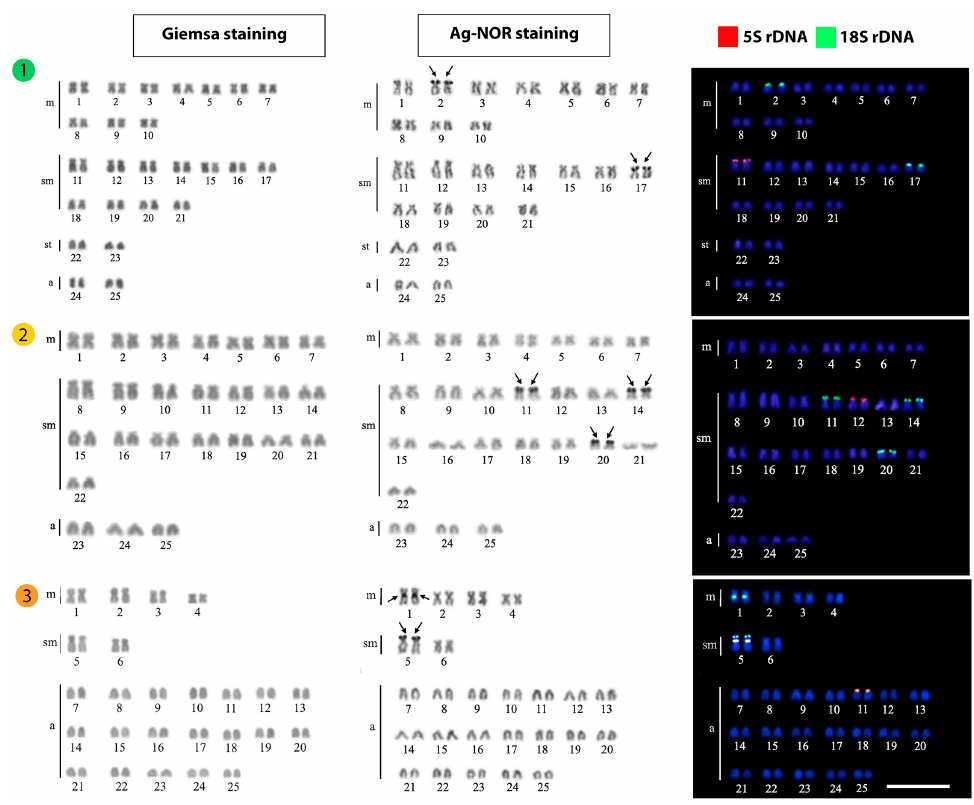
Figure 2. Karyotypes of ‘poropuntiinae’ species arranged from Giemsa- stained, Ag-NOR banding chromosomes (arrows) and chromosomes after FISH with 5S (red) and 18S (green) rDNA probes. 1 = C. harmandi ; 2 = C. apogon ; 3 = H. malcolmi . Chromosomes were counterstained with DAPI (blue). Scale bar = 5 µm.